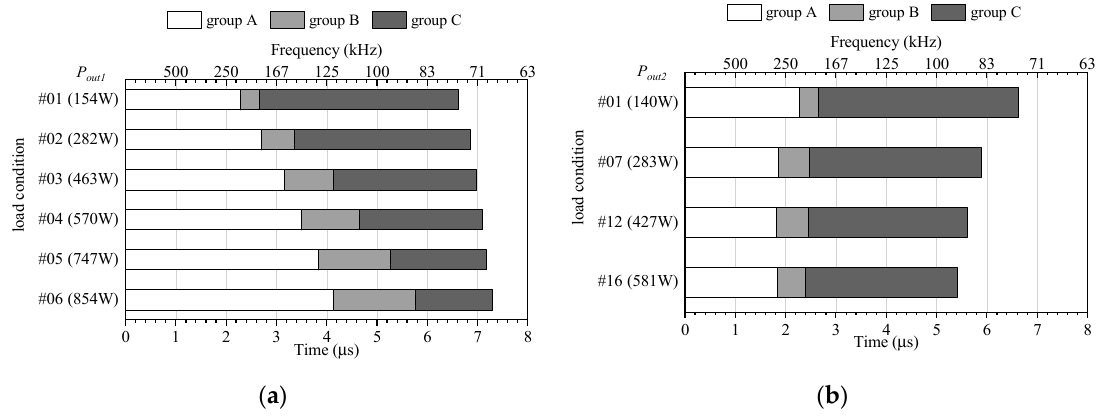
Figure 12. Occupied time and frequency of three operation modes: ( a ) P out 1 changes from 154 W to 853 W ( P out 2 = 142 W); ( b ) P out 2 changes from 140 W to 581 W ( P out 2 = 154 W).